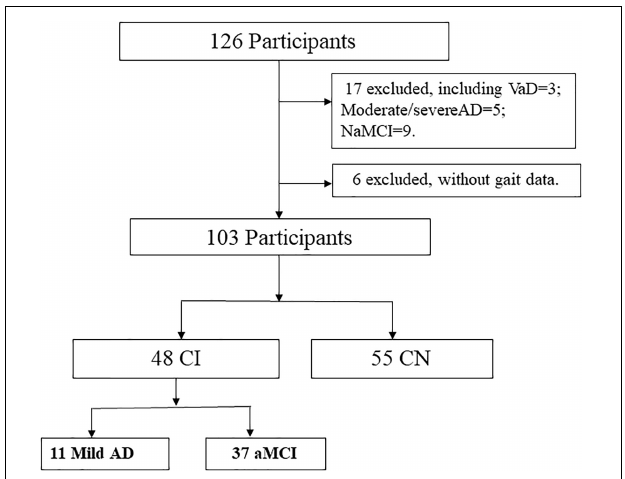
FIGURE 1 | Flow diagram of